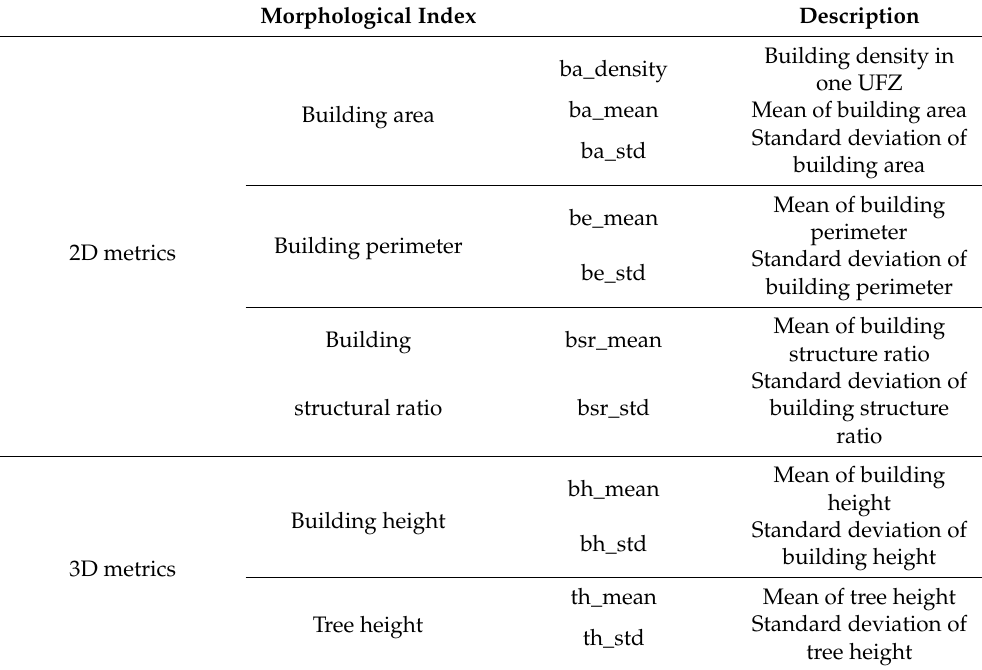
Table 4. Morphological indices of buildings and tree